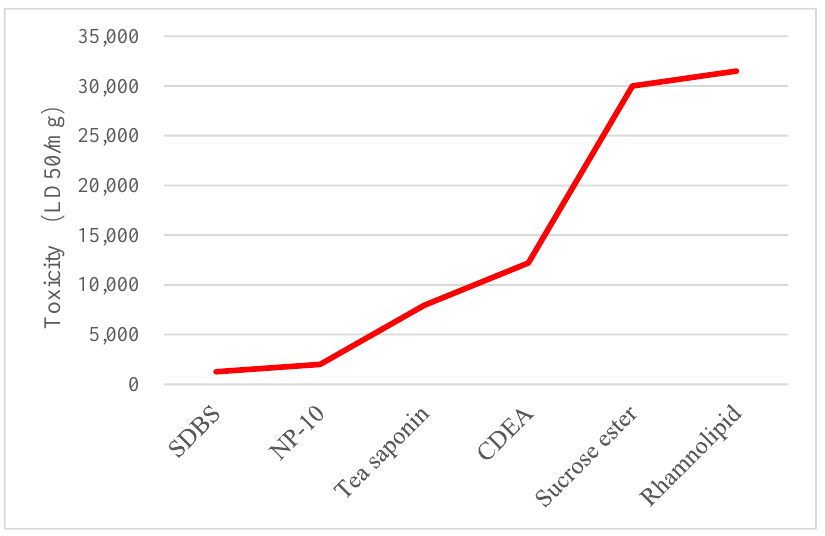
Figure 1. Toxicity indicators of the six surfactants (the higher LD 50 value, the safer the surfactant is).